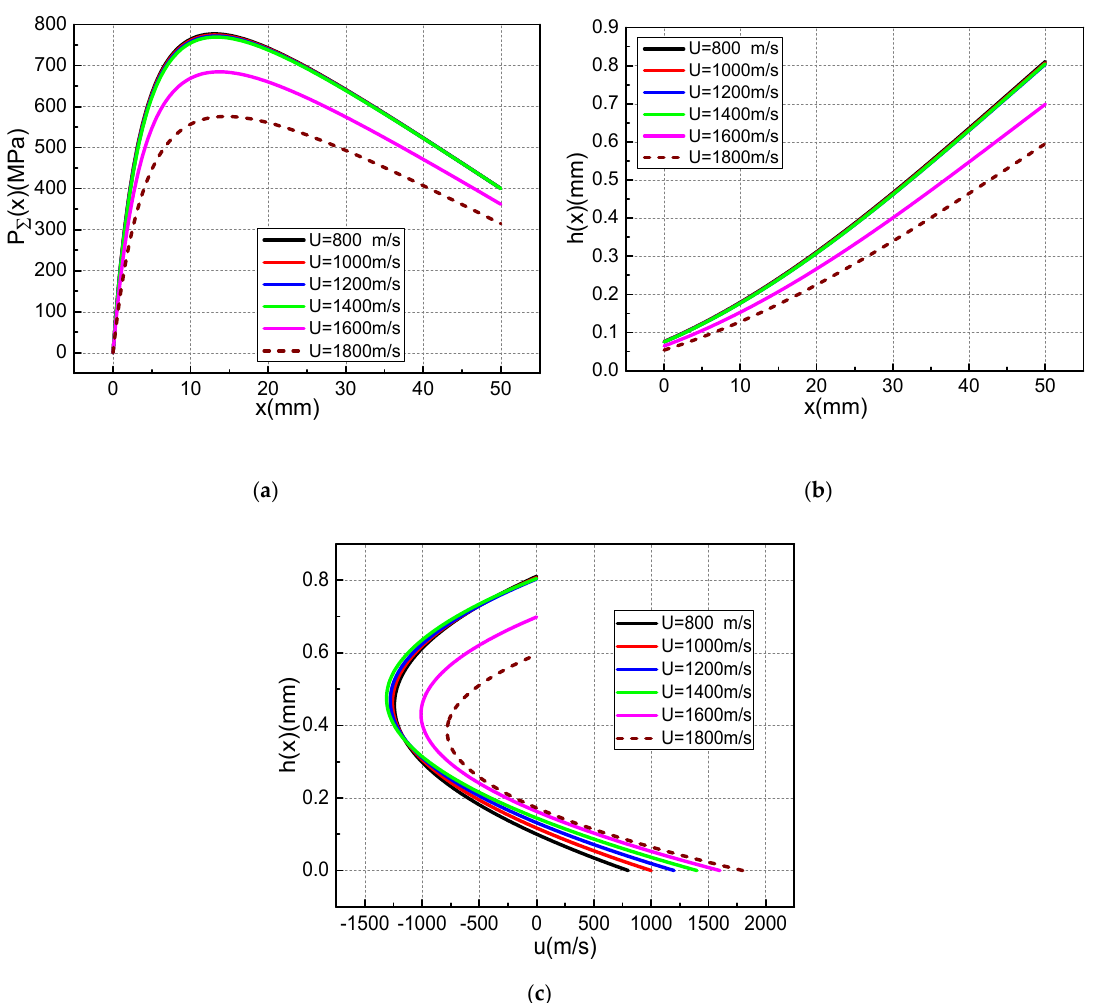
Figure 12. Distribution characteristics of total pressure, film thickness and velocity at the exit of metal liquid film at different armature velocity: ( a ) Total pressure distribution, ( b ) Film thickness distribution, ( c ) Velocity distribution at exit.